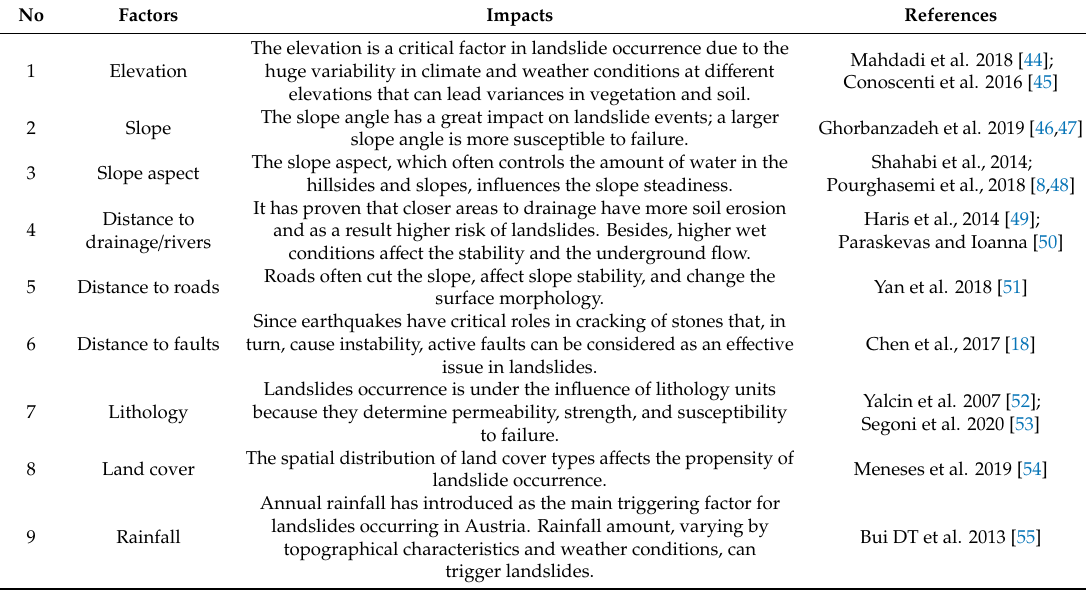
Table 1. A summary of the literature review of the importance of landslide conditioning